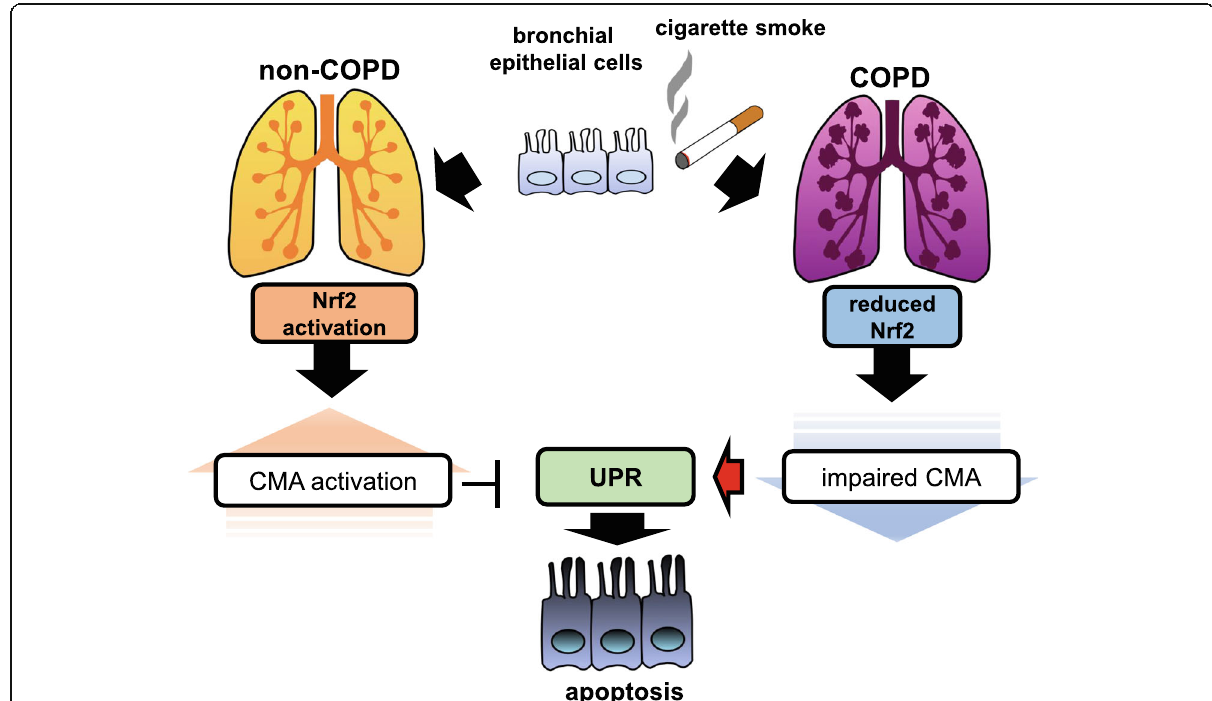
Fig. 4 Role of CMA in COPD pathogenesis. CMA activity is enhanced through Nrf2-mediated LAMP2A expression in response to cigarette smoke exposure. CMA prevent apoptosis by attenuating unfolded protein response (UPR) in non-COPD lung. Impaired CMA activity resulting from reduced Nrf2 expression leads to enhanced UPR with concomitantly enhanced apoptosis during COPD